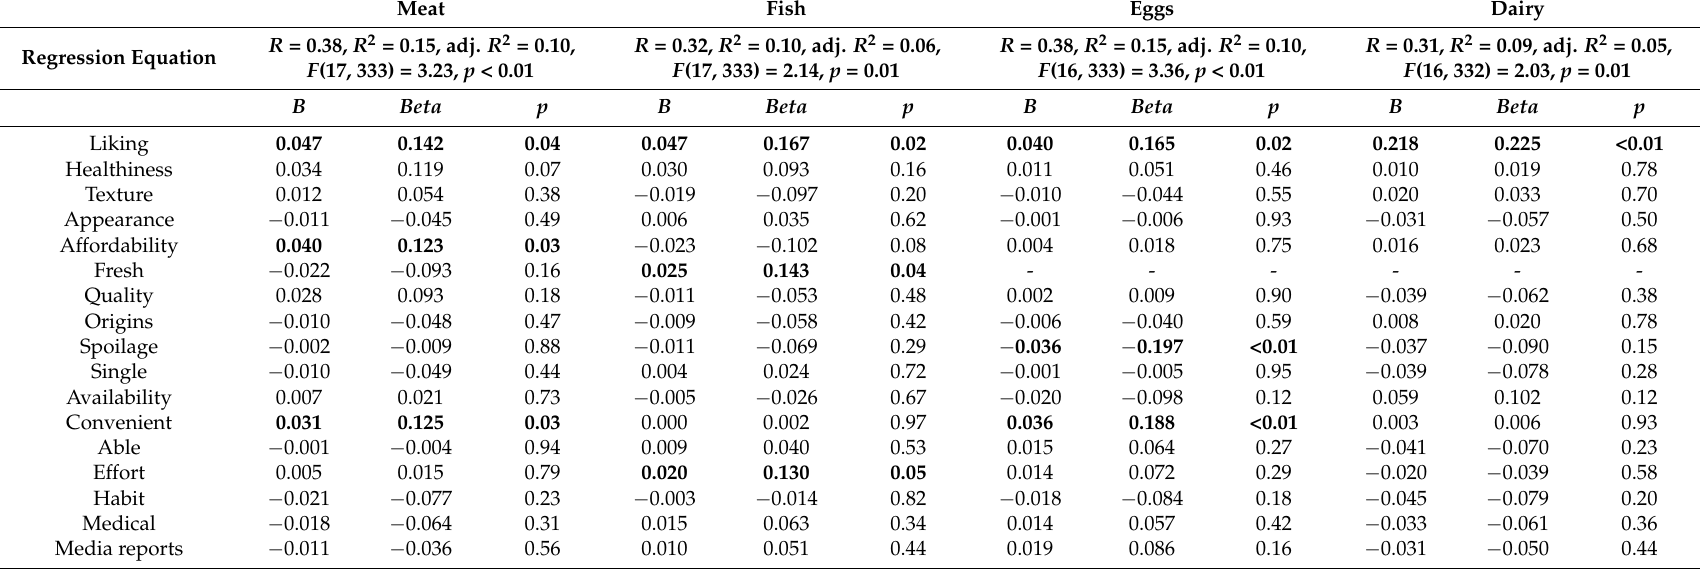
Table 2. Outcomes of the regression analyses investigating the impact of each of the barriers and facilitators for each food group studied. Meat Fish Eggs Dairy Regression